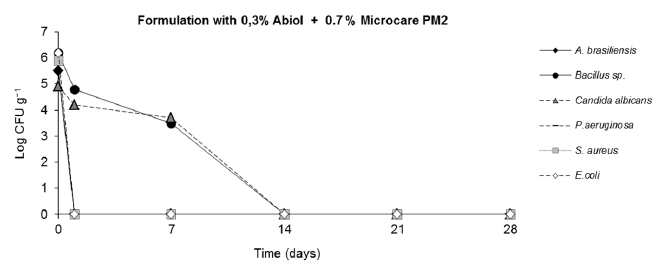
system nisin 125 ppm + 0.1% EDTA + 0.15% Abiol + 0.35% Microcare PM2.